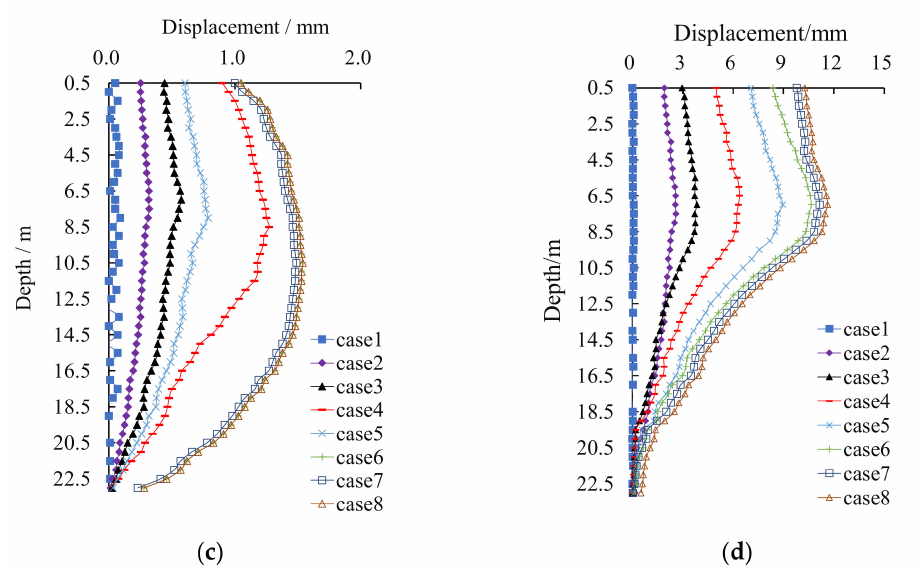
Figure 5. Horizontal displacement curves of piles under different working conditions: ( a ) ZQT-7,